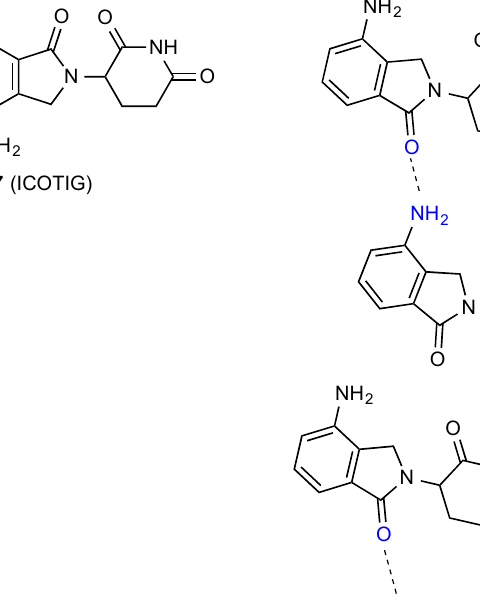
Figure 60. Structure adopted by compound 197.